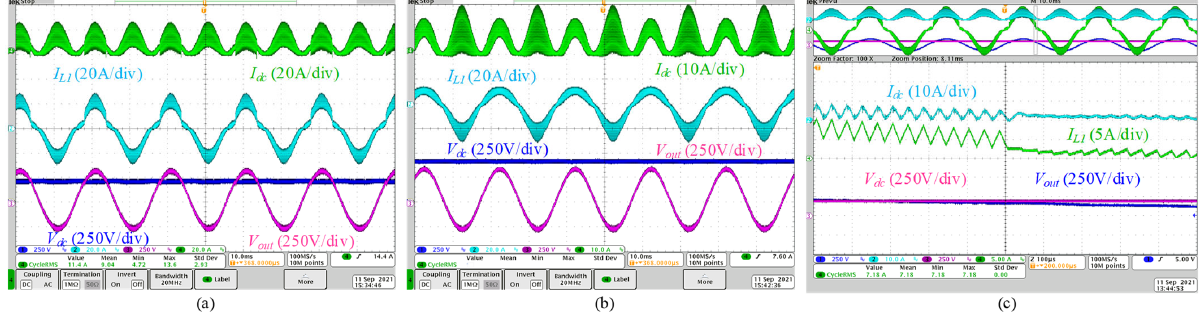
Figure 9. Experimental results in asymmetrical operation mode: I dc , I L bottom, respectively; ( a ) at the input voltage of 200 V and output power of 1.5 kW, ( b ) at the input voltage of 400 V and output power of 2 kW, and ( c ) zoom mode of I dc and FI current at V dc of 150 V and output power of 1